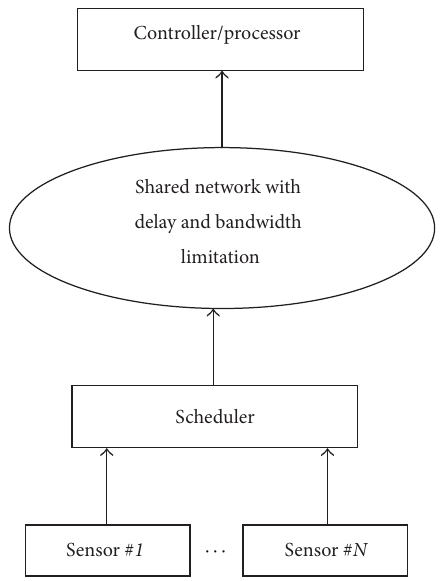
Figure 1: Several sensors using a shared